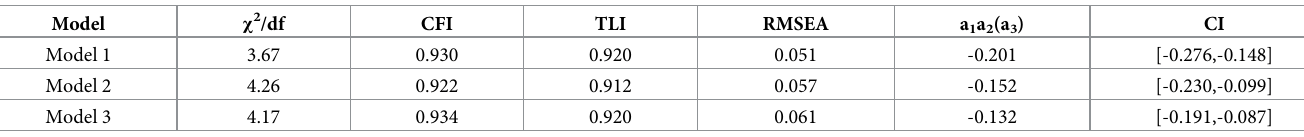
Table 2. The model fit indices and the test results of mediation effects of Model 1, 2, 3. Model χ 2